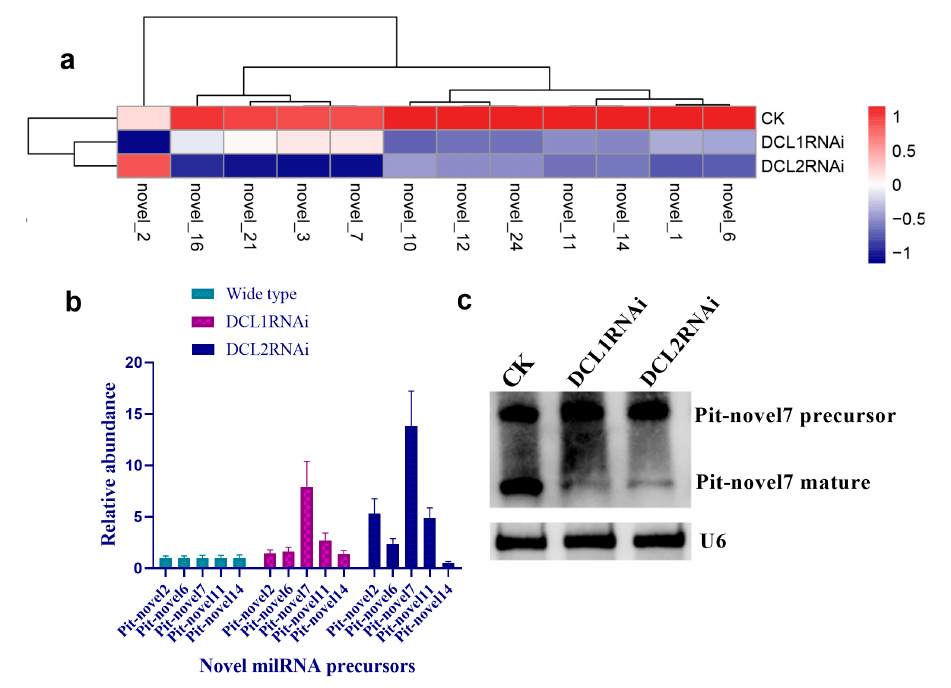
Figure 6. Characteristics of novel microRNA-like RNAs (milRNAs) in P. italicum. Heatmap of the differentially expressed milRNAs based on small RNA sequencing ( a ). RT-qPCR analysis of the precursors of the novel milRNA precursors ( b ). Northern blot analysis of Pit-novel7 milRNA, and U6 was used as an internal reference ( c ).